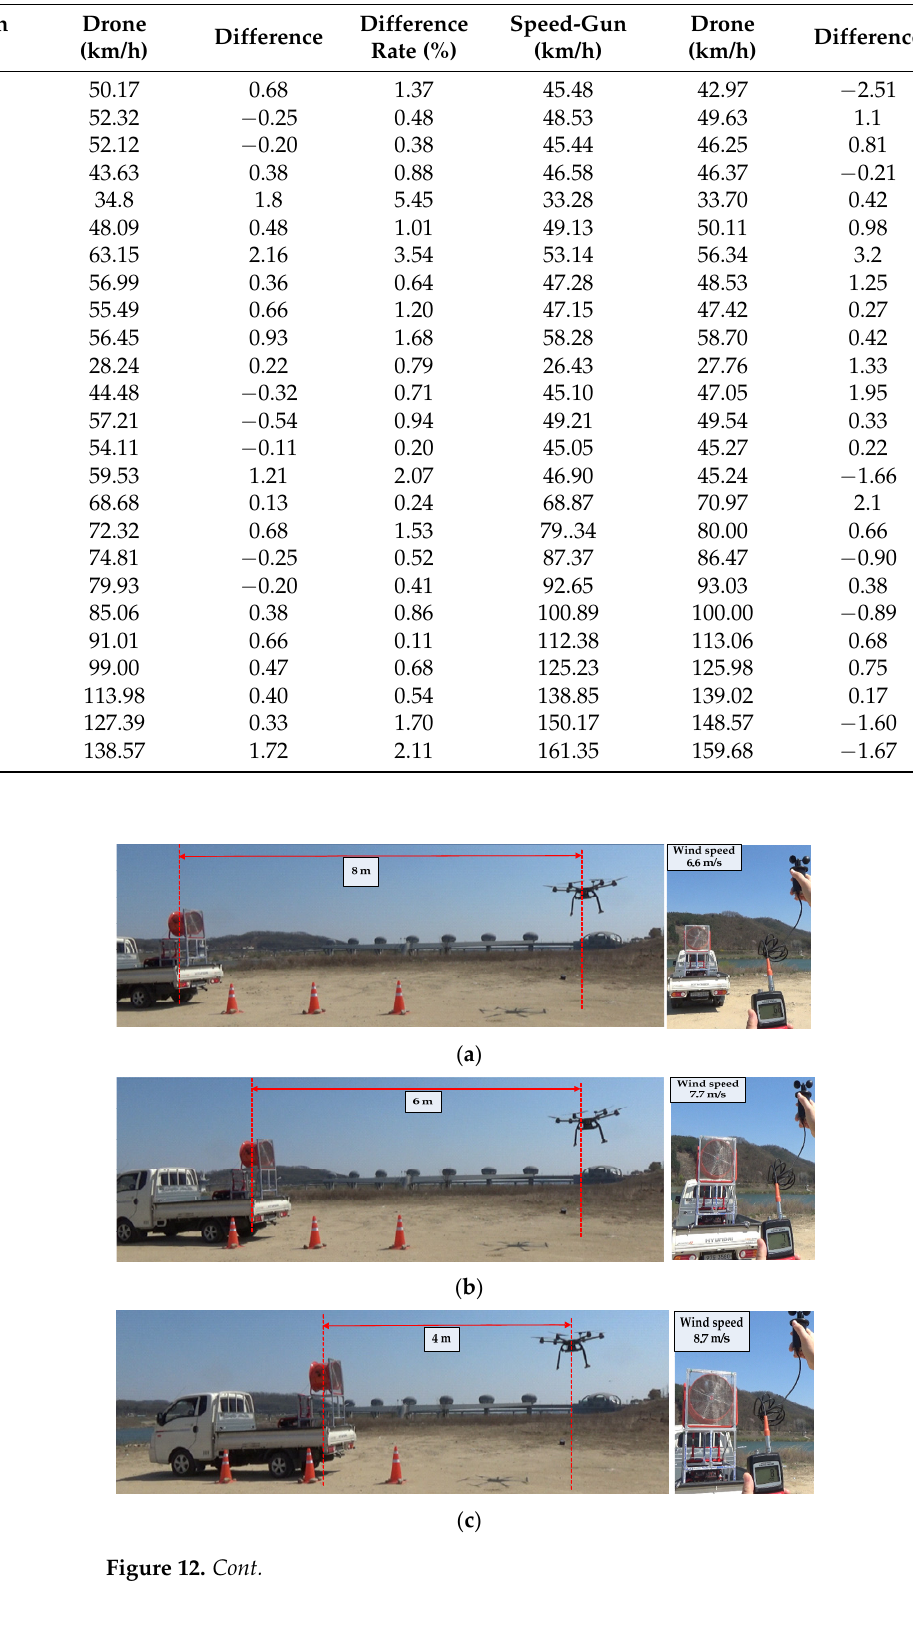
Table 1. Comparison of the vehicle measurements for the speed gun and the drone on the multi-lane. Measurement Velocity on First Lane